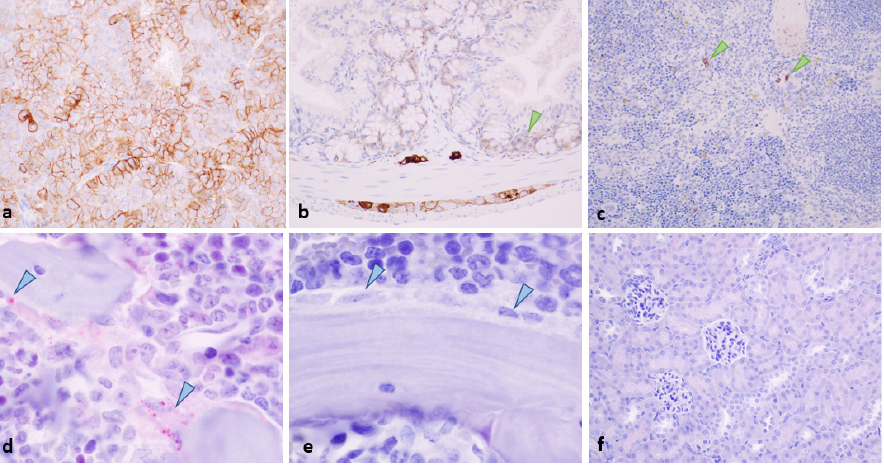
Figure 7. SST 2 expression in the ( a ) adrenal medulla, ( b ) colon (including the enteric nervous system and epithelial crypt cells, arrowhead), ( c ) spleen (rare lymphoid cells, arrowheads), and ( d ) bone marrow osteoblasts (arrowheads). The isotype control antibody confirmed the specificity of the staining in the different tissues, as in the bone marrow ( e ). SSTR2 was not detected in the kidneys ( f ). Figures ( a – c , f ) were taken using the objective 40, and figures ( d , e ) were taken using the objective 100.